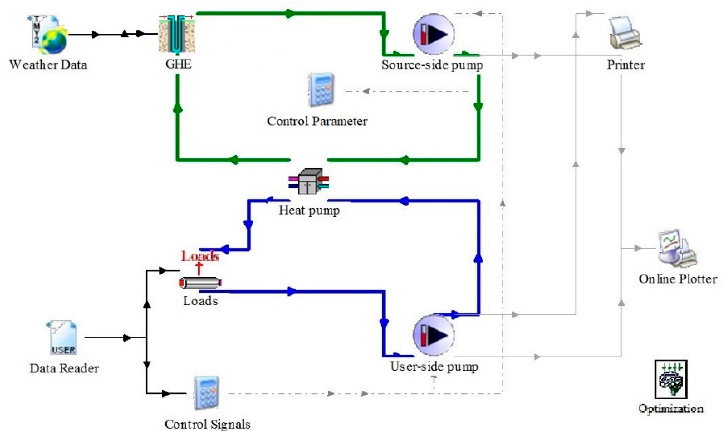
Figure 6. Layout of the DST-based sizing method.